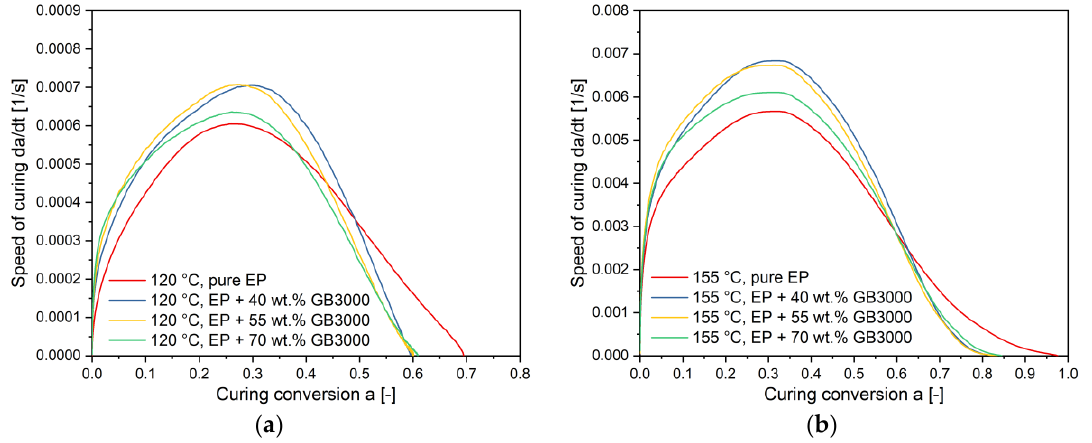
Figure 12. Curing speed versus curing conversion for compounds with different filler content at ( a ) 120 °C and ( b ) 155 °C.